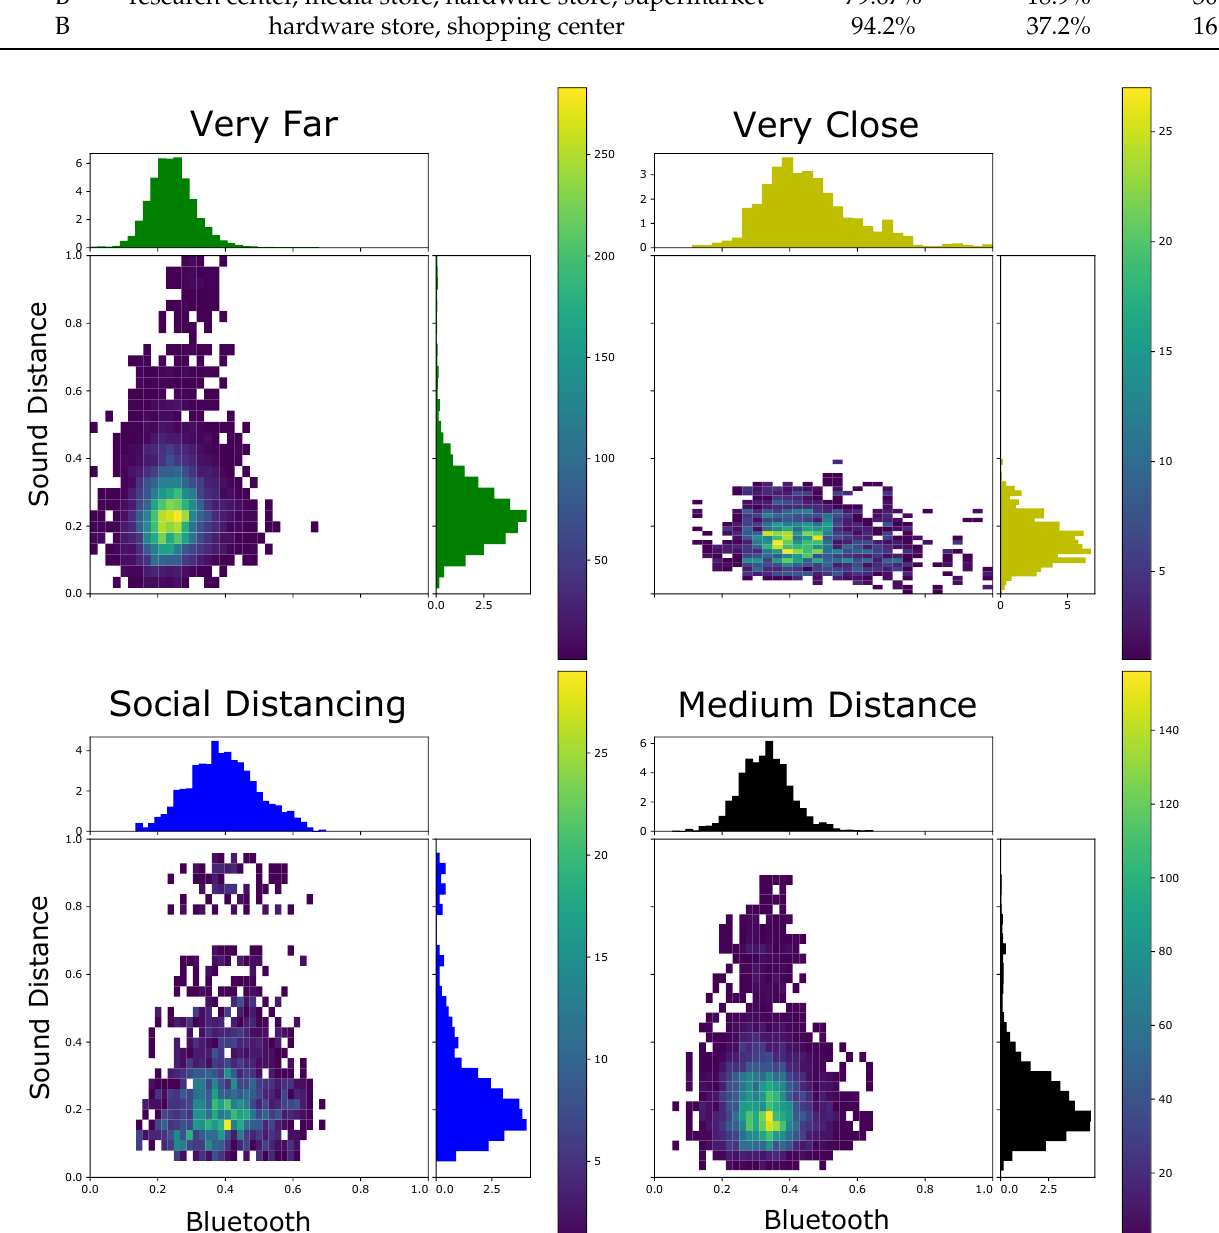
Figure 10. Distribution of features for all our 5 s windows that had acceptable sound. The sound feature represents the dissimilarity of the sound between the two subjects and was calculated using the one minute averaging, while the Bluetooth one represents the minimum pre-processed Bluetooth signal recorded by the subject of the other. Participants who were very close experience similar sound features, and thus sound similarity can solve some of the ambiguity present using only Bluetooth